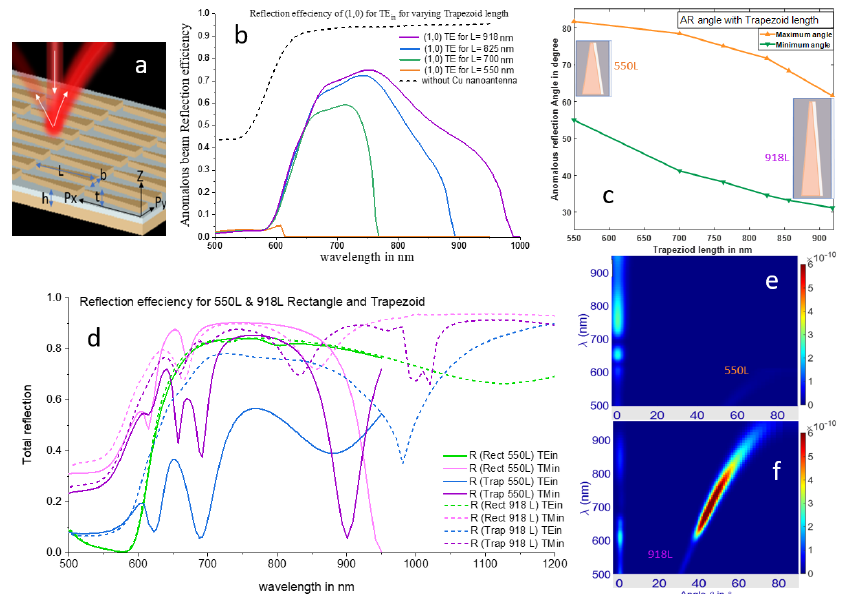
Figure 1. ( a ) A schematic of the Cu metasurface; ( b ) the broadband anomalous reflection efficiency of the four different length trapezoids, as mentioned in Table S1 in the Supplementary Materials; ( c ) the minimum and maximum angle coverage from the anomalously reflected beams; ( d ) a comparison of the total broadband reflection efficiency of the 918L (dashed line) and 550L (solid line) trapezoids and the rectangles for both the TE and TM incidences; ( e ) the angle-resolved far-field reflection magnitudes depending on the wavelength for the TE incidence for the 550L trapezoid and ( f ) the 918L